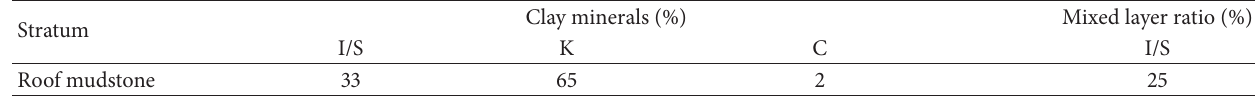
Table 2: X-ray diffraction analysis of clay minerals.